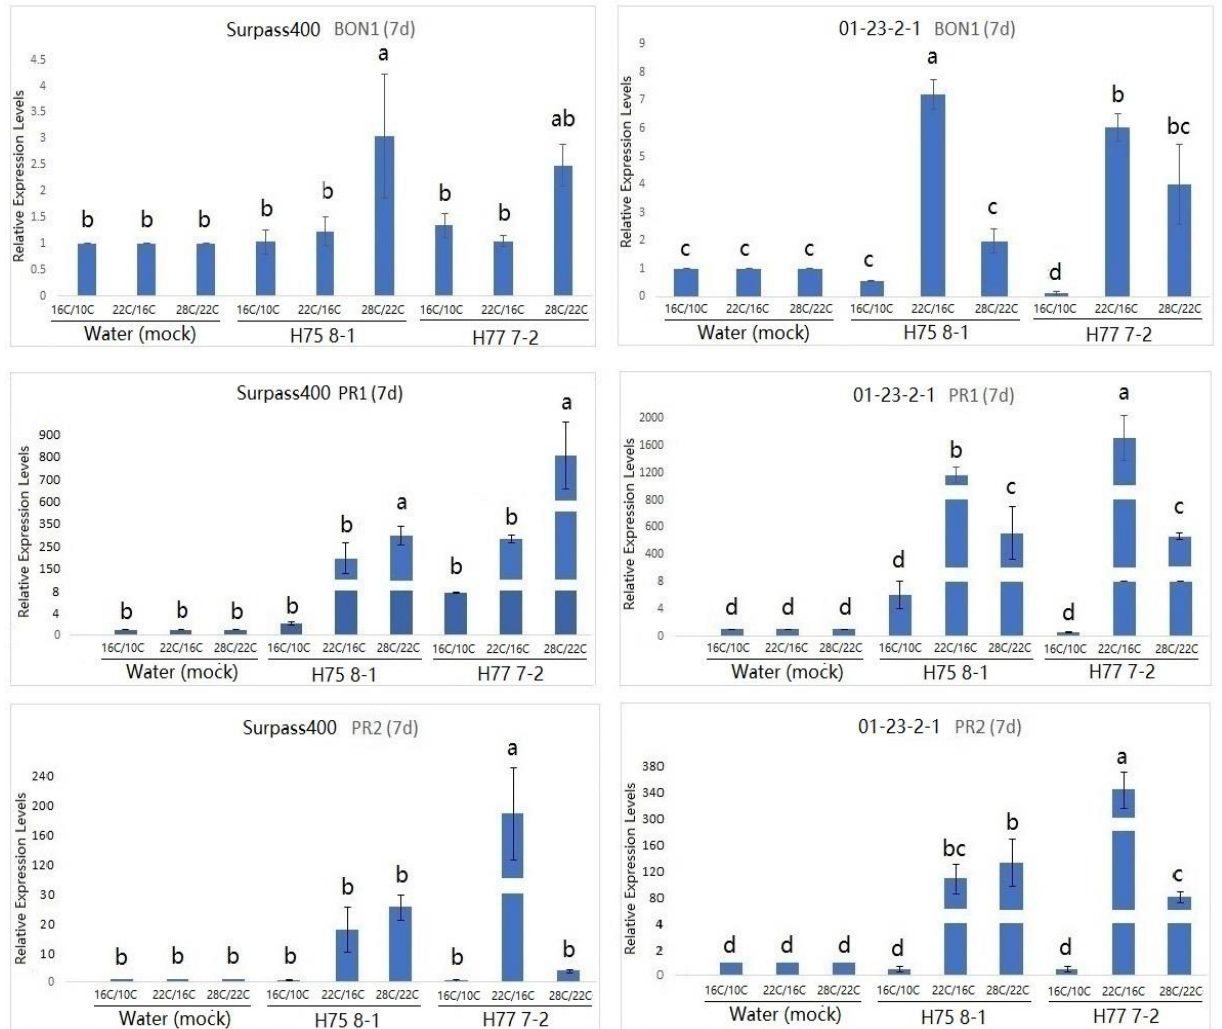
Figure 3. Gene expression of temperature-dependent regulator BONZAI1 (BON1) , PATHOGENESIS-RELATED ( PR)1 and PATHOGENESIS-RELATED ( PR)2 (in B. napus ) in the regulation of hormonal signals at 7 dpi from Surpass400 and 01-23-2-1 inoculated by the blackleg isolates HCRT75 8-1 and HCRT77 7-2. The inoculated plants were exposed to three temperature treatments: 16 ◦ C/10 ◦ C, 22 ◦ C/16 ◦ C and 28 ◦ C/22 ◦ C (day/night: 16 h/8 h). The levels of the bars are the expression levels obtained from the inoculated cotyledons (inoculated by H75 8-1 and H77 7-2) compared to the cotyledons inoculated with water (assuming that the expression of each studied gene in the cotyledons inoculated with water is 1). Error bars represent standard error of the mean. Different lowercase letters suggest the significant differences among mean values (Fisher’s Least Significant Difference; p < 0.05). The results are based on three replicates in three independent experiments.